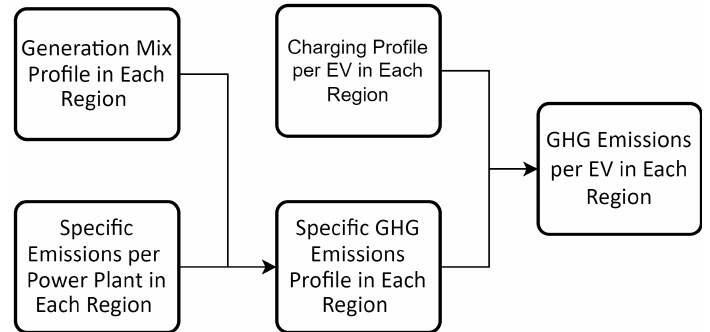
Figure 3. Evaluation of GHG emissions. In the evaluation of the impact on the electrical grid, different charging profiles were used and matched with the renewable generation and demand profiles, as presented in Figure 4. The uncoordinated charging profiles per charging level from different U.S. cities (with the percentage of daily consumption that occurs in each hour) [27] were used to extract the charging profiles per location (considering home, work, and public charging) in each region, CP L , R . Such profiles, CP L , R (with the percentage of the daily energy demand h h that occurs in each hour), together with the electricity consumption per EV per day, CD EV h (in kWh/day), and the considered number of EVs per region, EV R , allowed to evaluate the charging demand per location in each region, CD L , R (in kW), using Equation (4), as well as h the total charging demand in each region, CD R (in kW), using Equation (5) (taking L the h value of 1, 2, and 3 for home, work, and public charging, respectively).